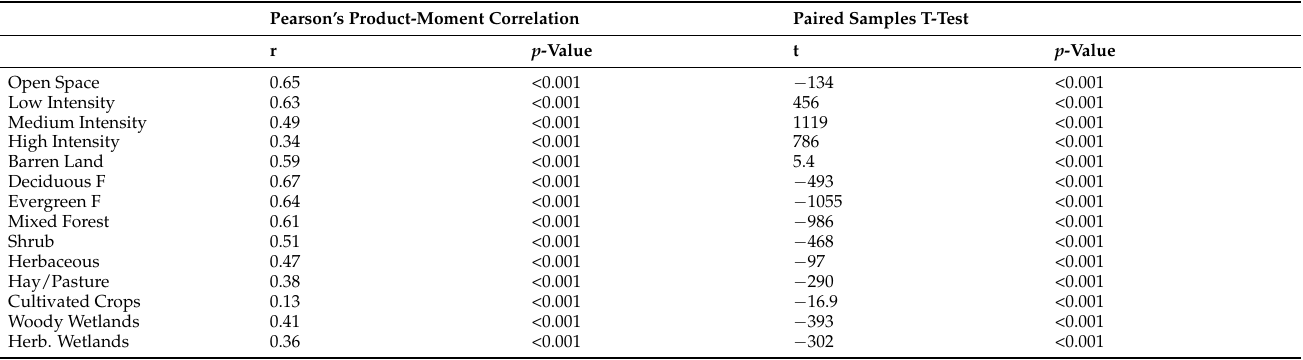
Table 5. Statistics for Portland. A Pearson’s correlation coefficient (r) is a measure of the linear correlation between two sets of data ( − 1 ≤ r ≤ 1).